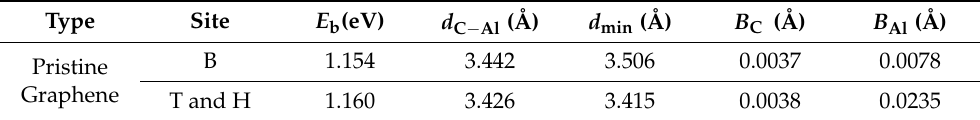
Table 1. The key parameters of the pristine graphene/Al (111) interface after optimization.